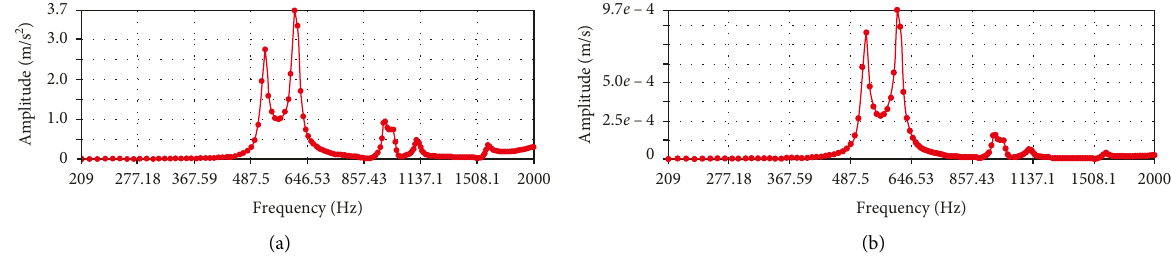
Figure 13: The results of the optimized wheel simulation.